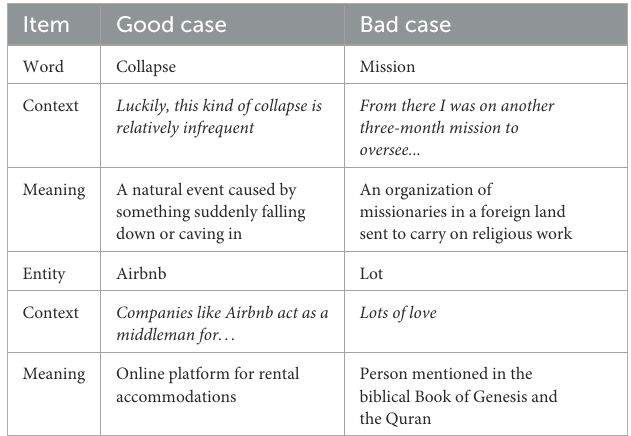
TABLE 3 Good and bad cases for new word and entity identification.